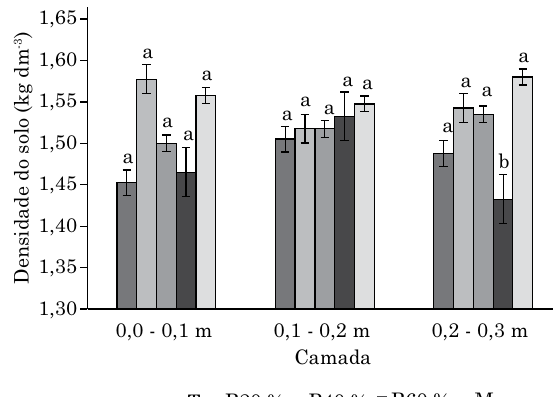
Figura 2. densidade de partículas, com os erros da média, para as áreas sob cultivo de figo e mata secundária (T - Testemunha; B20 % - Biofertilizante 20 %; B40 % - Biofertilizante 40 %; B60 % - Biofertilizante 60 %; e M - Mata nativa). Médias seguidas pela mesma letra na camada não diferem pelo teste de Dunnett (p≤0,05).